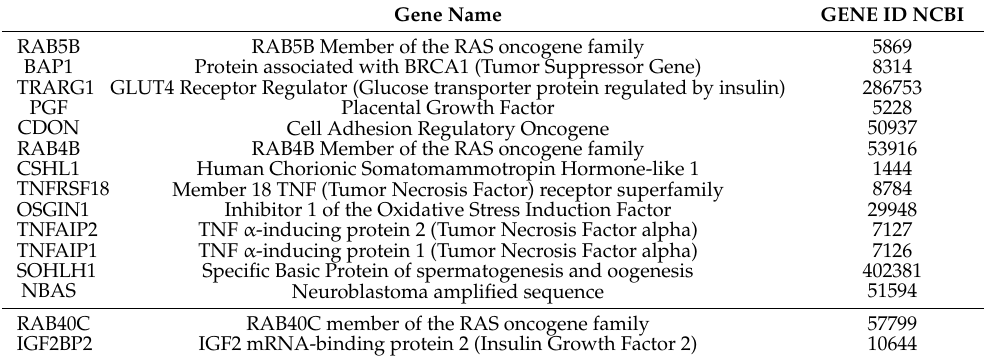
Table 5. Targets of miR-3918.